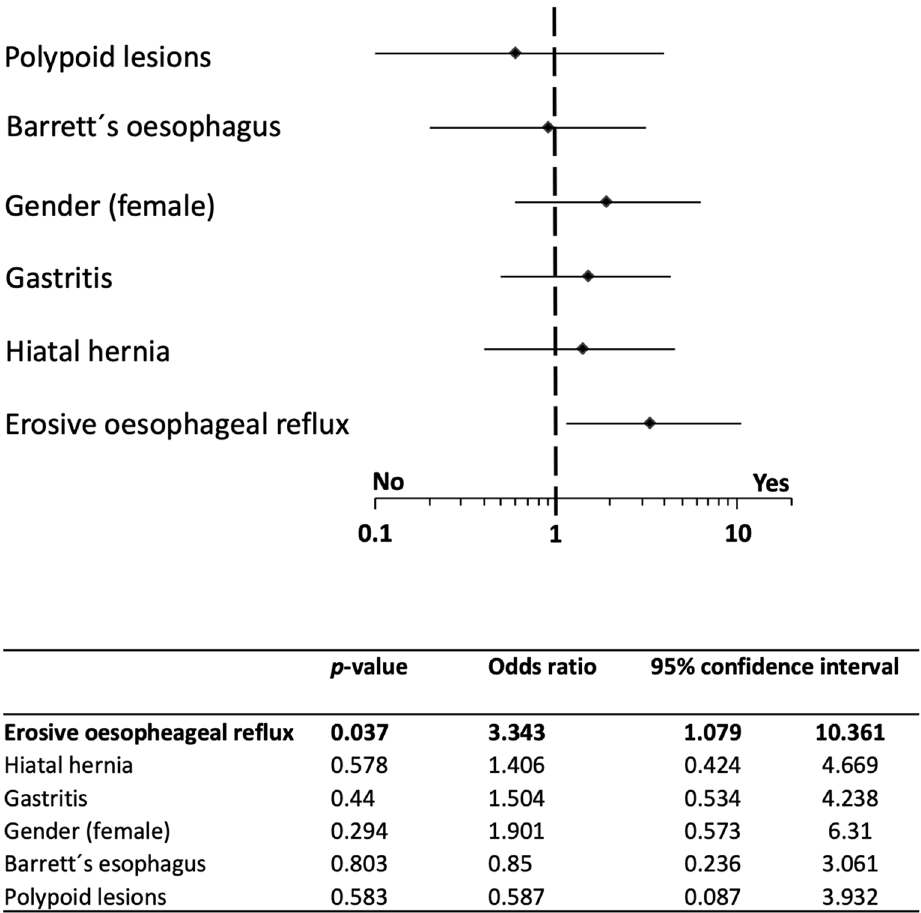
Figure 2. Analysis of pre-existing upper gastrointestinal pathologies as risk factors for PVI-associated mediastinal oedema. Multinomial logistic regression to calculate odds ratios with 95% confidence intervals identified mild to severe erosive oesophageal reflux disease as risk factors for post-ablation mediastinal oedema. PVI, pulmonary vein